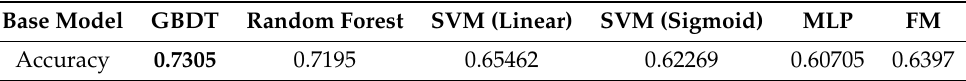
Table 1. The accuracy test of different base